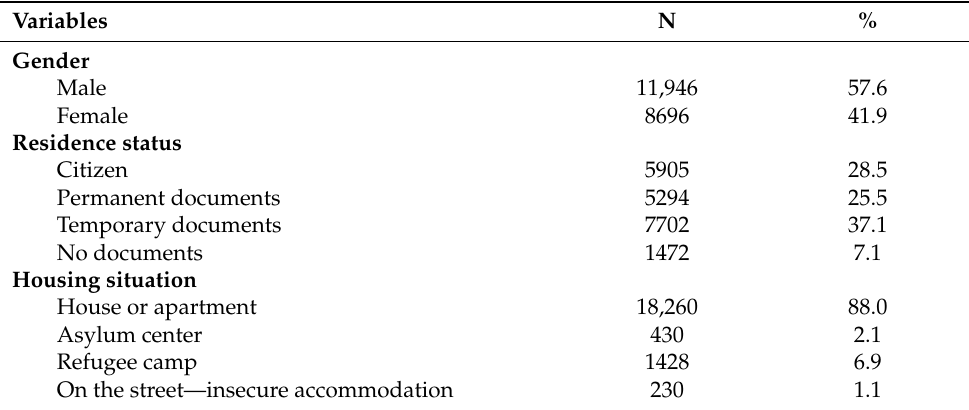
Table 1. Demographic characteristics of the